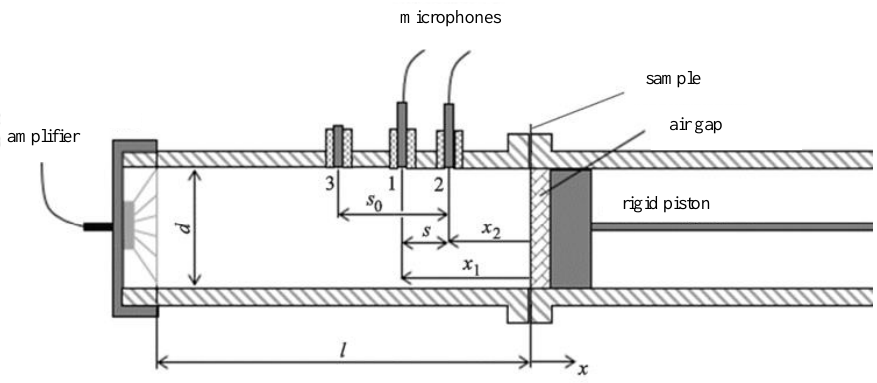
Figure 6. Diagram of measurement inside the two-microphone impedance tube type 4206.